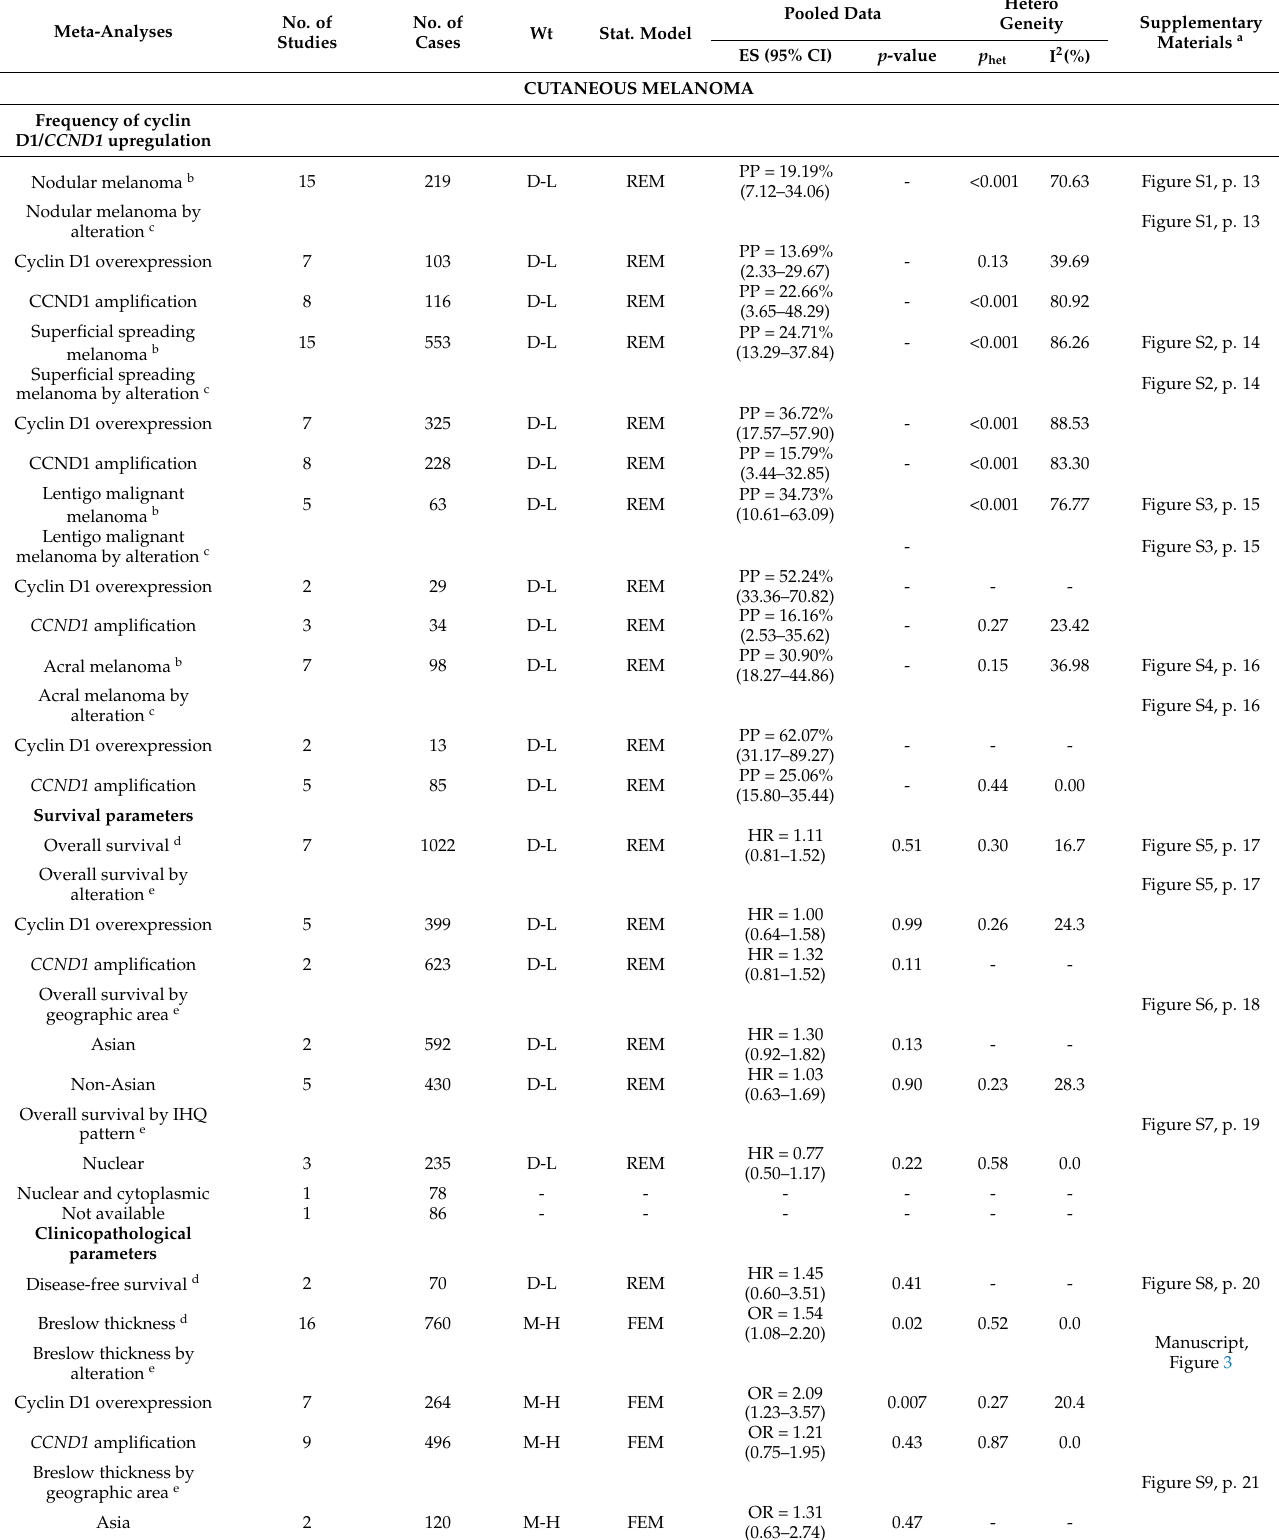
Table 2. Cyclin D1/CCND1 upregulation in melanoma: frequency, clinicopathological, and prognostic significance.